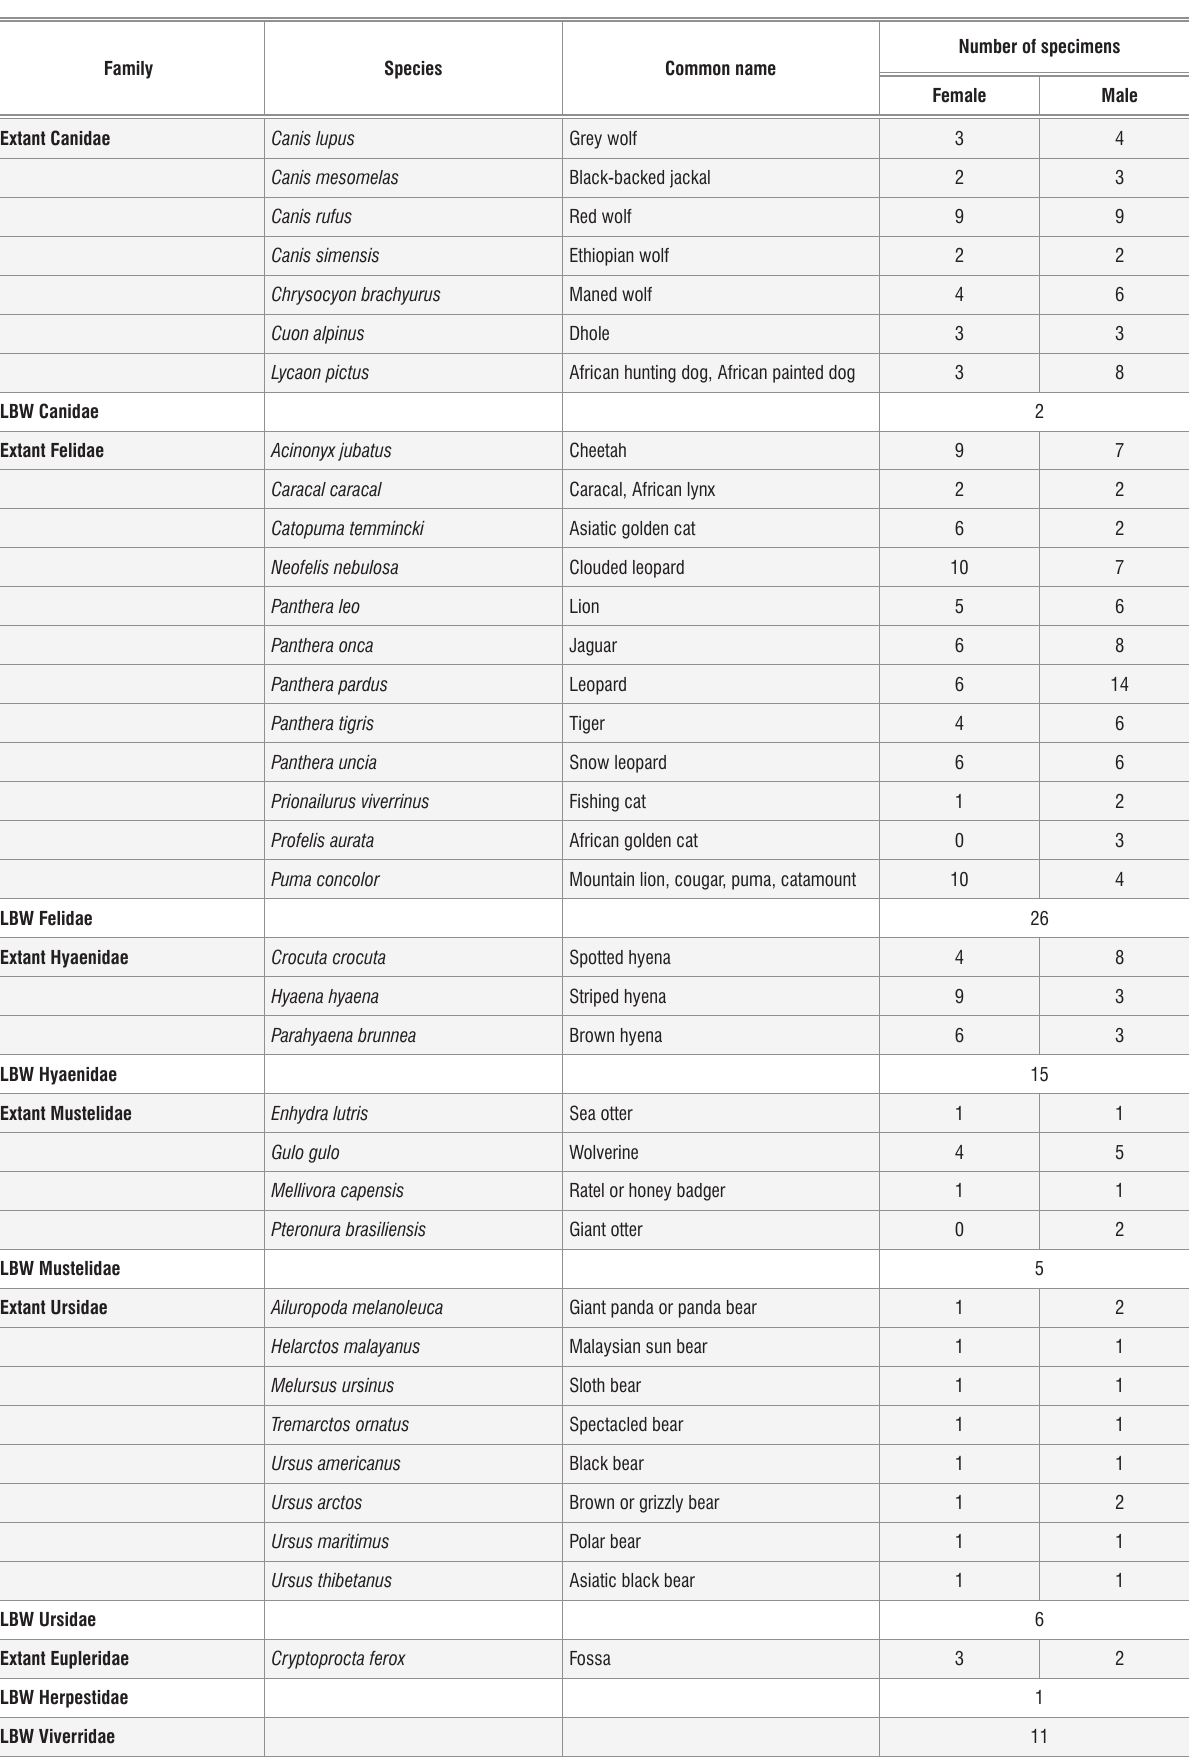
Table 1: Specimens studied by family: Extant species and Langebaanweg (LBW) confamilials